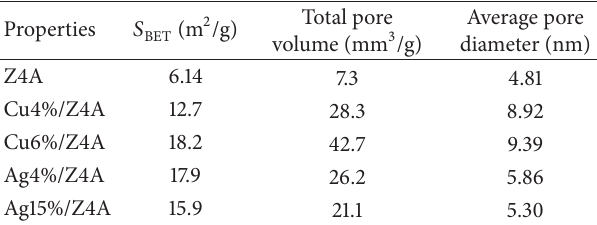
Table 2: Specific surface area, total pore volume, and average pore